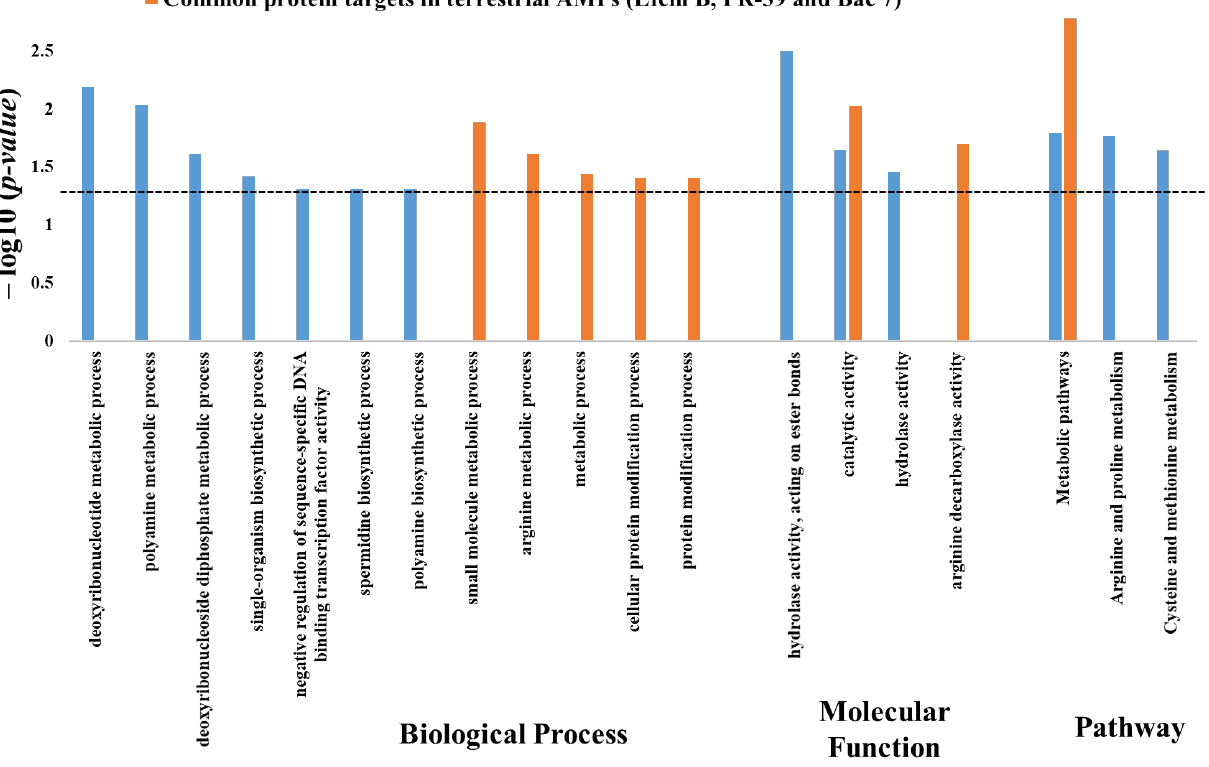
Figure 7. Comparison of enrichment terms obtained from the enrichment analysis of the common protein targets of marine AMPs (polyphemusin-I and P-Der) and terrestrial AMPs (Lfcin B, PR-39 and Bac 7). Enrichment analysis of common protein targets of marine AMPs (polyphemusin-I and P-Der) as well as for the common protein targets of terrestrial AMPs (Lfcin B, PR-39 and Bac 7) were performed, individually. The enrichment results were compared in GO biological process, molecular function and pathway. The p -value cutoff of ≤ 0.05 were applied to select the significant enrichment terms (dotted line represent p -value = 0.05).